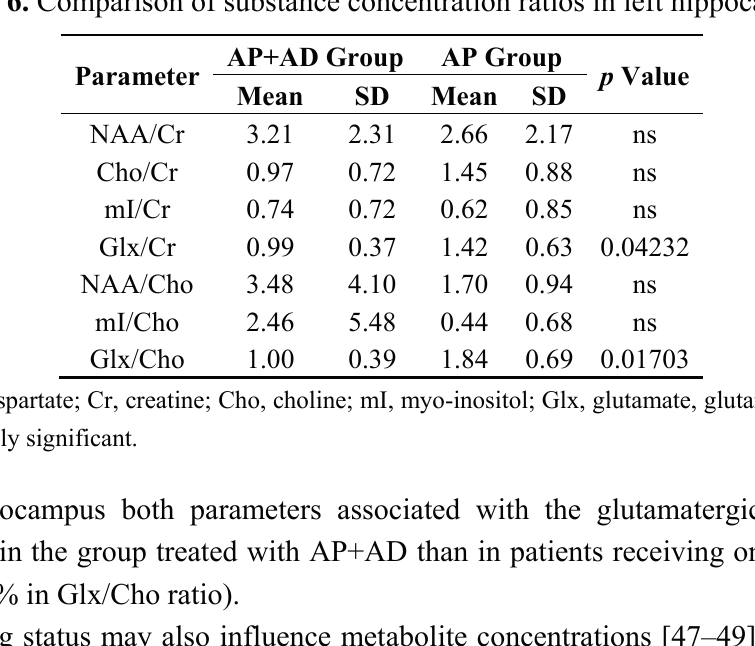
Table 6. Comparison of substance concentration ratios in left